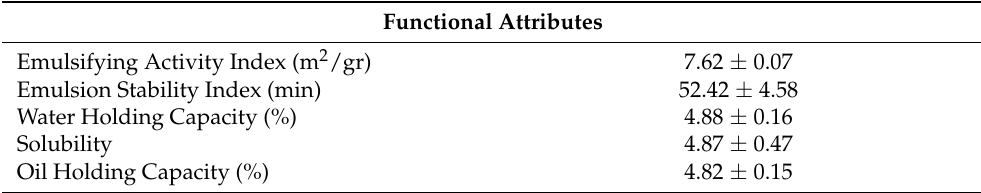
Table 4. Functional properties of mushroom protein by-products.